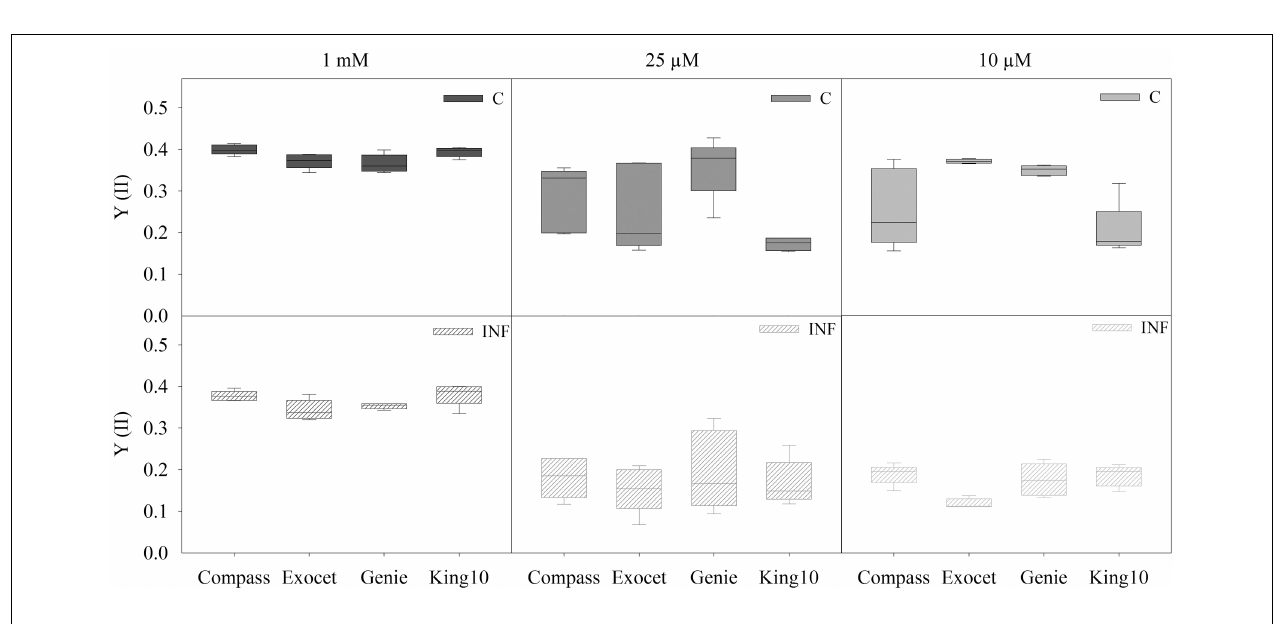
interest (AOI). The performances were obtained for 10min after 20min of dark adaptation. Data are represented as box plots. Filled boxes present non-infected plants (C) and striped boxes the corresponding results of infected plants